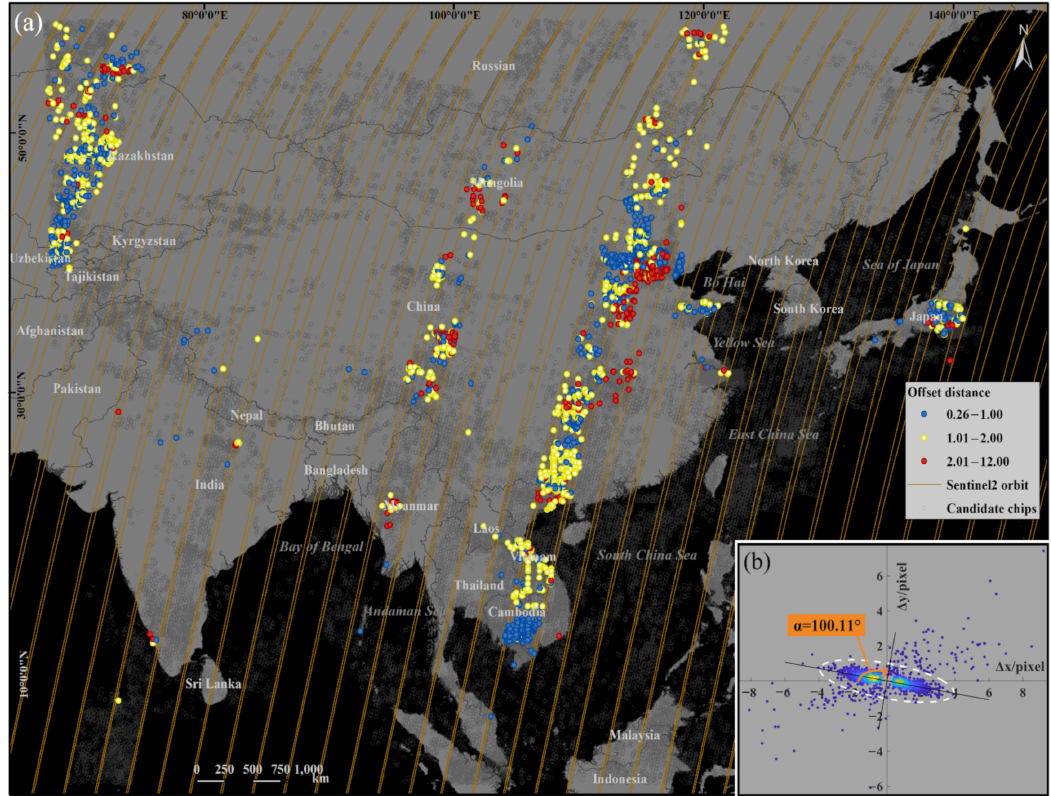
Figure 5. Spatial distribution of image chips with detectable BBMR. ( a ) Distribution of chips around China and its neighboring areas. The chips detected with BBMR were graded by the offset distance with different colors, and other candidate chips were represented by gray circles. ( b ) Sets the offset position of 4356 detected chips to a rectangular coordinate with a fitting ellipse (covered 96.06% chips) centered on the